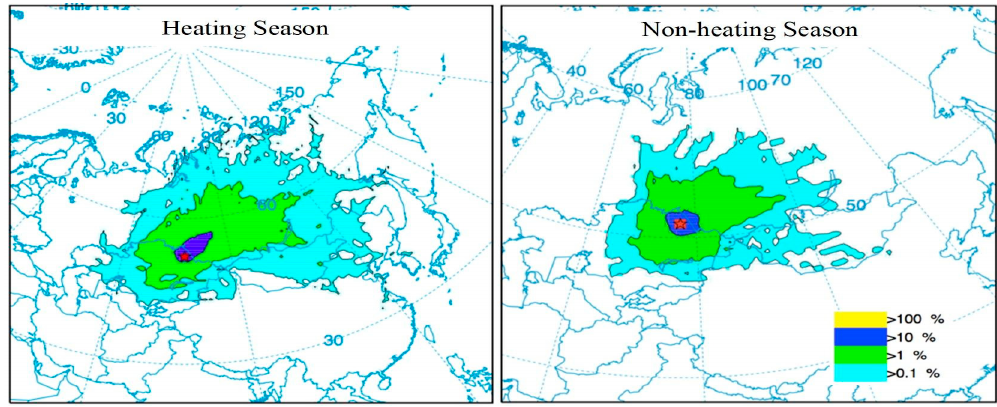
Figure 5. Most frequently influenced locations (areas of impact) by air parcels originated from region of pollution source.